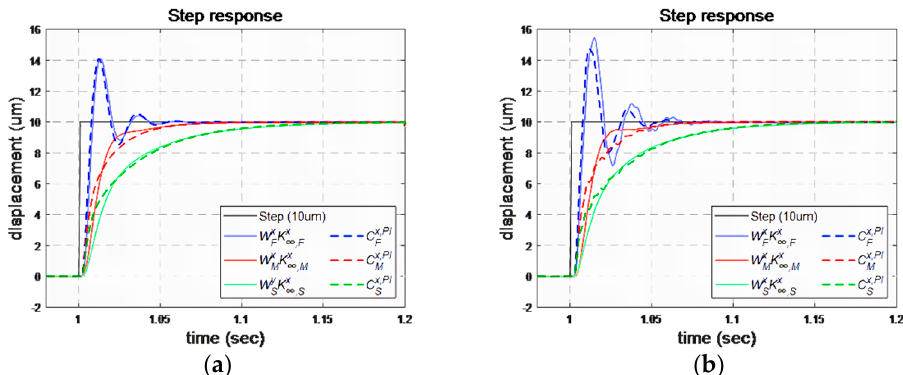
Figure 5. Comparison of the standard robust controllers and the robust PI controller: ( a ) simulation; ( b ) experimental results. Table 2. Statistical comparison of the controllers.